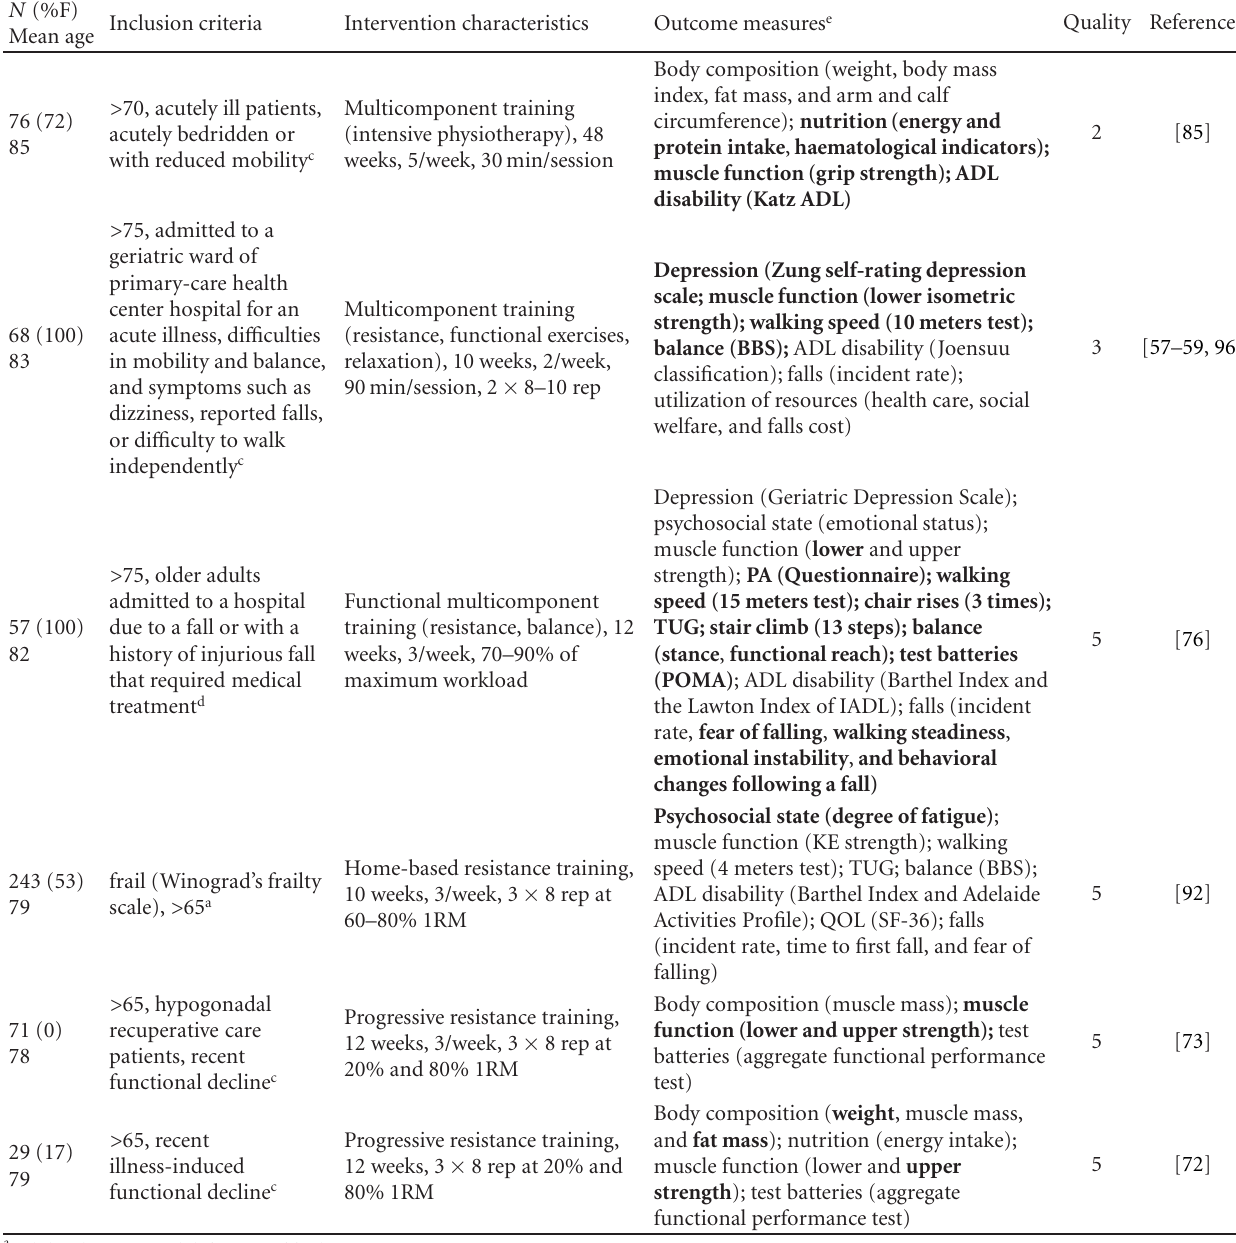
Table 4: Description of studies that included hospitalized older